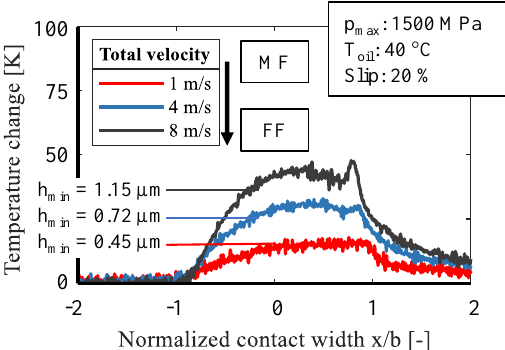
Figure 6. Influence of pressure at fluid friction on temperature change.